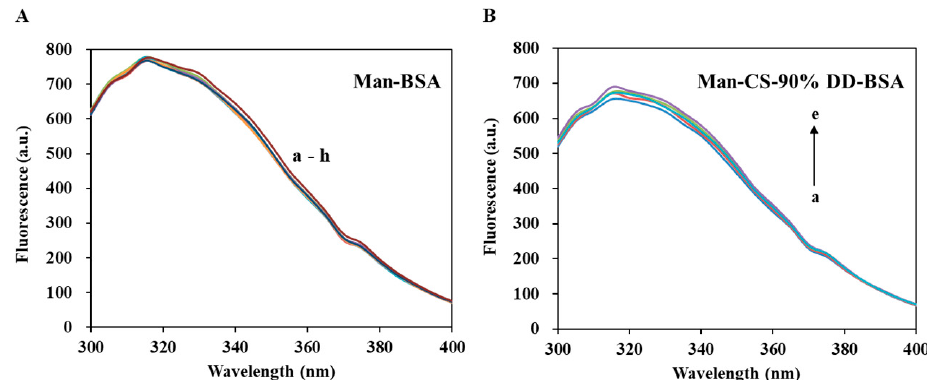
Figure 9. Fluorescence spectroscopy of Man-BSA and Man-CS-90%DD-BSA complexes: ( A ) Man-BSA, the concentrations of Man are with values of a–h (0, 1, 2, 3, 4, 5, 6 and 7 mg/mL); ( B ) Man-CS-90% DD-BSA, the concentrations of Man are with values of a–e (0, 1, 2, 3 and 4 mg/mL). In conclusion, the 90% DD CS we selected in this research, has an appropriate binding constant with BSA, which is required to balance the encapsulation and release of BSA in BSA- CS-NPs and Man-BSA-CDS-NPs. The formation of CS-BSA adducts can improve the stability of BSA. Furthermore, the Man we added into Man-BSA-CDS-NPs decreased the binding constant between CS and BSA slightly, which may reduce of BSA encapsulation efficiency.